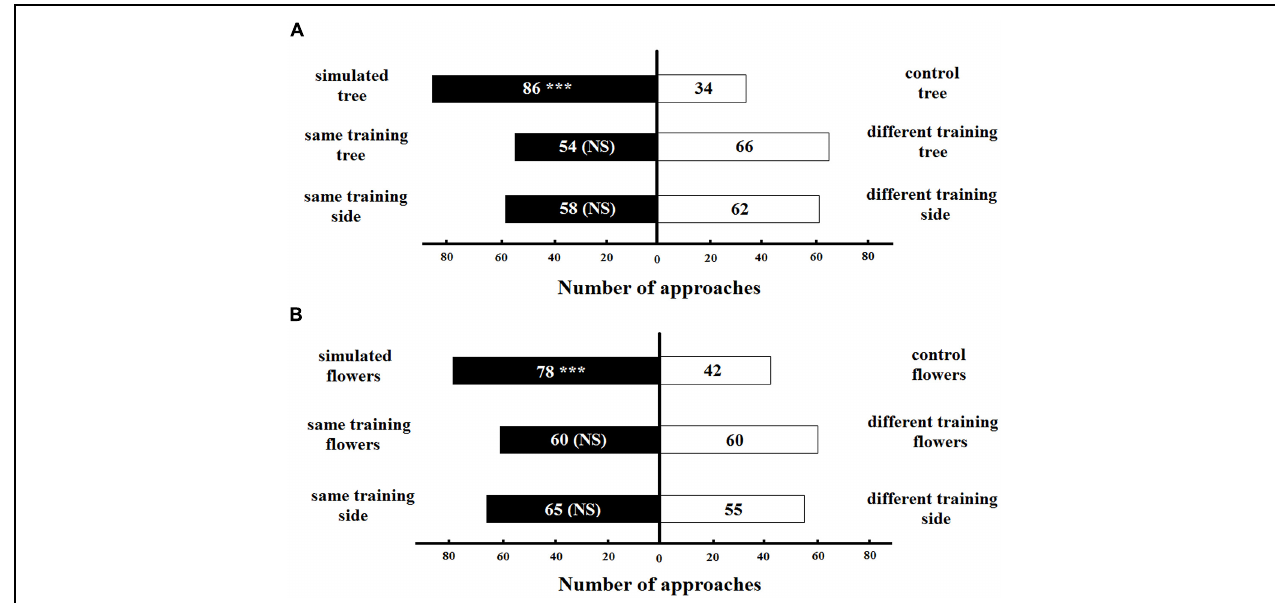
FIGURE 6 | Number of bee approaches in (A) long-distance experiment and (B) short-distance experiment simulating color patterns of T. pulchra . ∗∗∗ < 0.005 significance using a logistic regression model. NS,